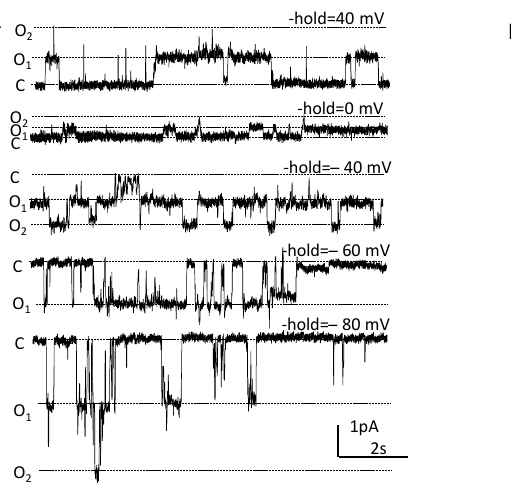
Figure 2. The NPRC agonist cANF inhibits EnNaC activity in hAoEC. Representative single-channel recordings ( A ), I-V curve of EnNaC ( B ), and summary plot of EnNaC activity (NPo) ( C ). A Student t -test was used to compare the control (Ctrl) and cANF experimental groups. n = 30 patches for the control group and n = 34 patches for the cANF group. * represents a p -value < 0.05.